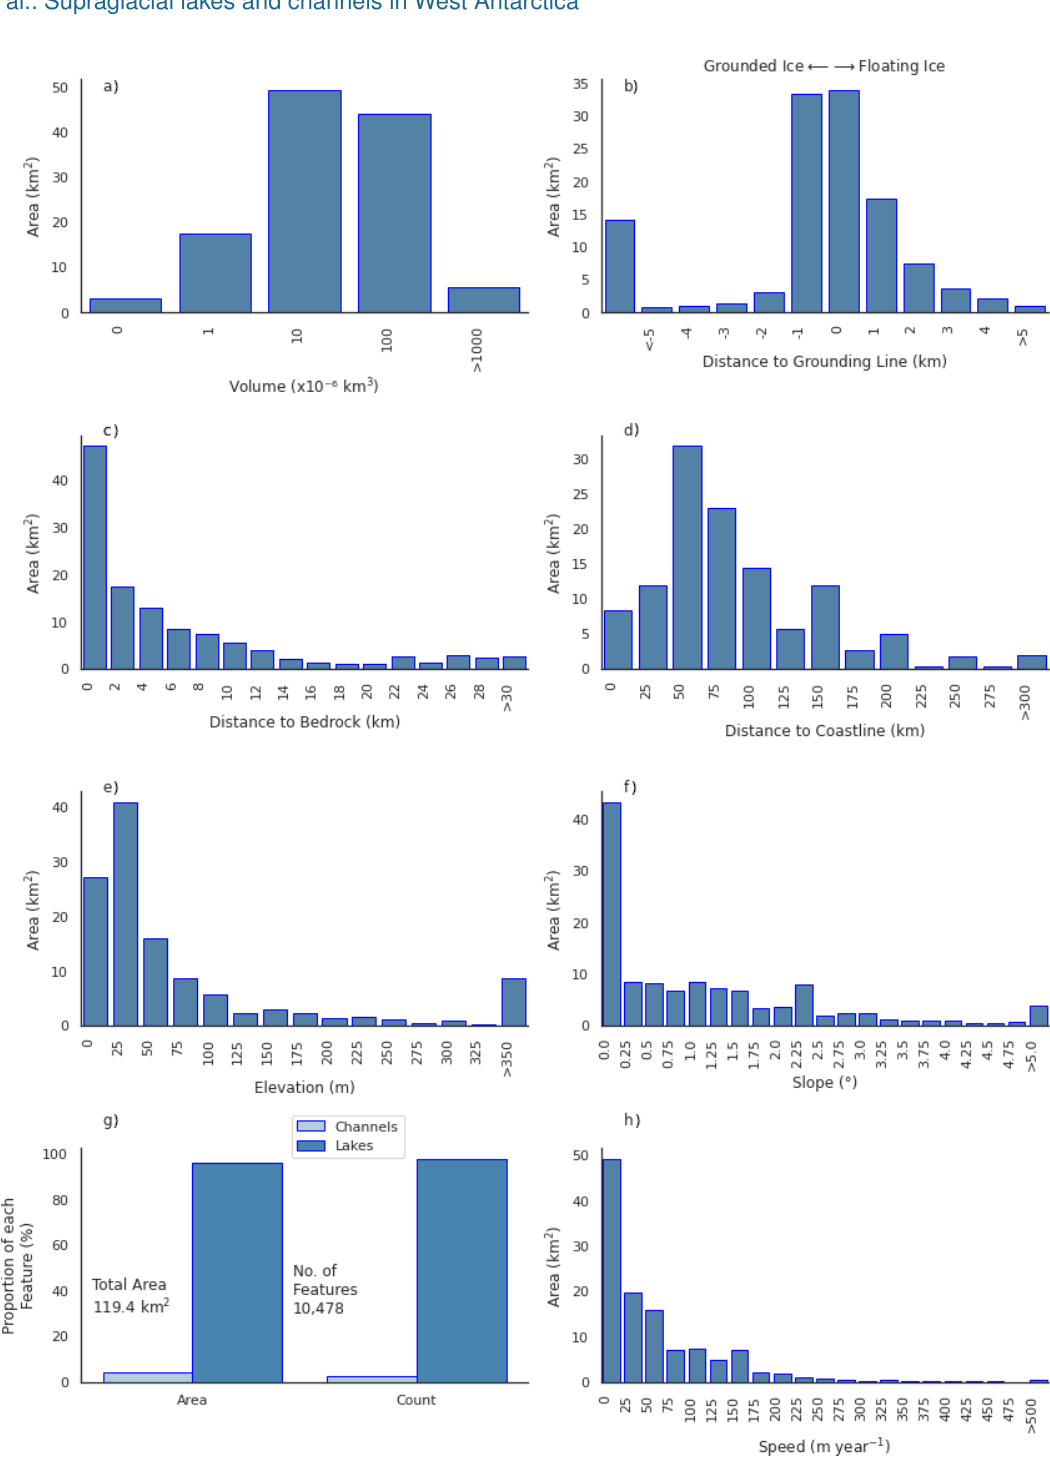
https://doi.org/10.5194/essd-14-209-2022 Earth Syst. Sci. Data, 14, 209–228,